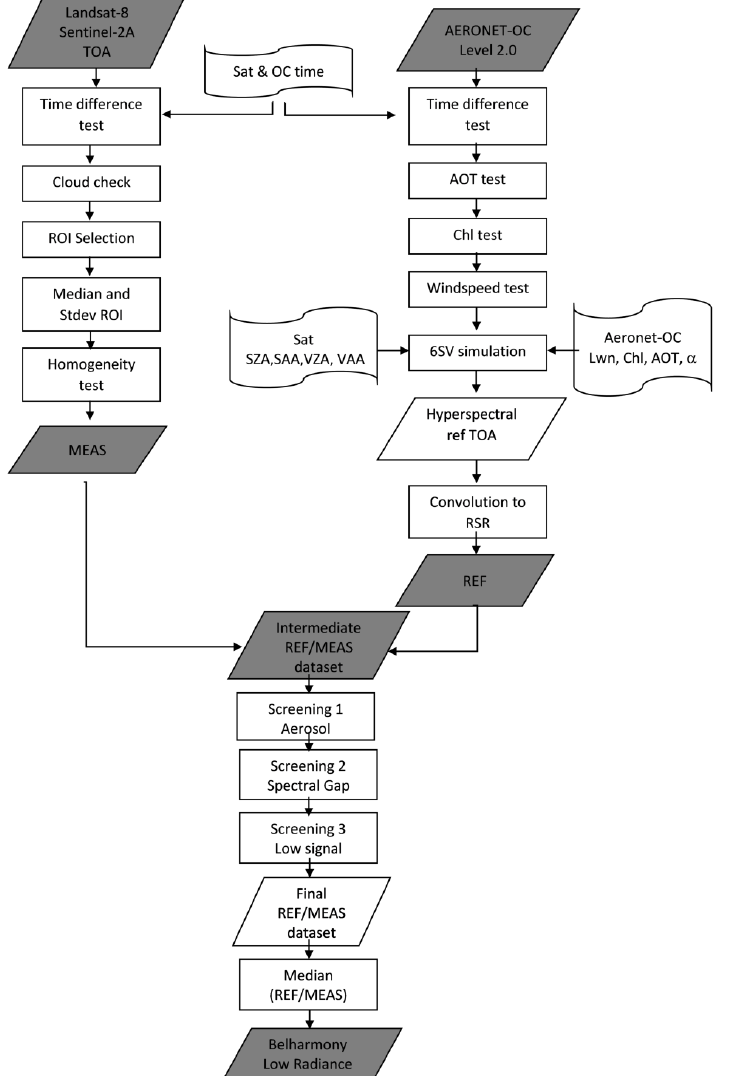
Figure 4. Flow chart of the procedure developed for gains retrieval when low radiance water is acquired by a satellite sensor.